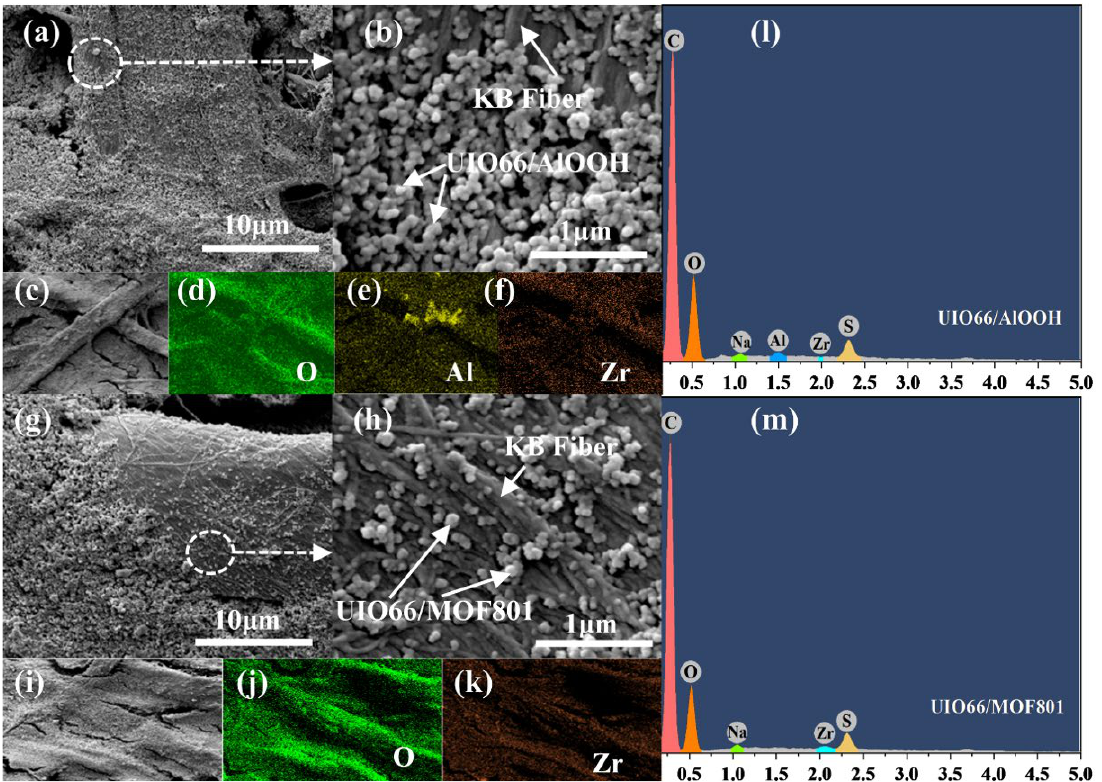
Figure 3. ( a , b ) SEM images of UIO66/AlOOH-KBF and its ( c – f ) EDS mapping; ( g , h ) SEM images of UIO66/MOF801-KBF and its ( i – k ) EDS mapping; EDS spectrum of ( l ) UIO66/AlOOH-KBF and ( m ) UIO66/MOF801-KBF. ( m )